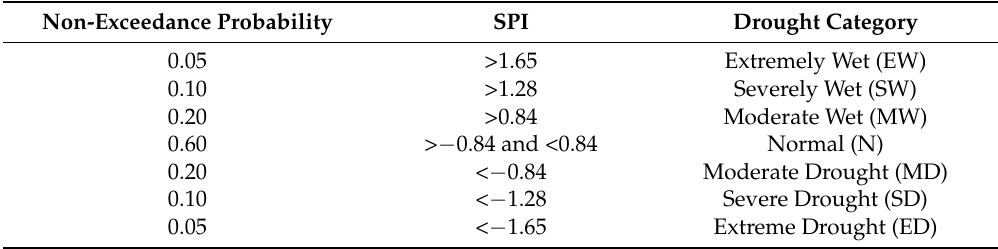
Table 1. Drought categorization based on SPI